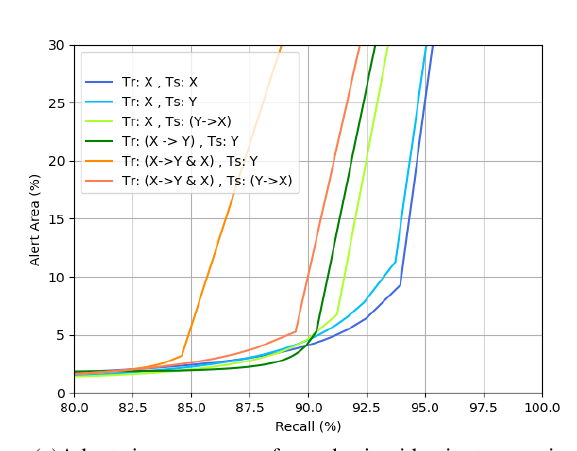
(a)Adaptation process performed using identity term as in Equation 8.